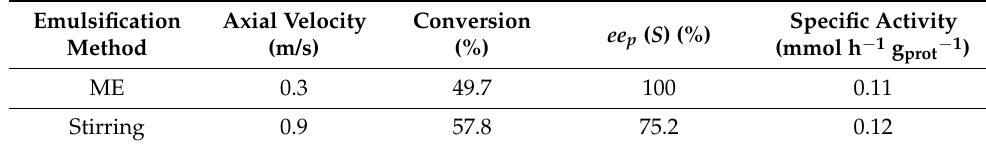
Table 2. Enantiomeric excess, conversion, and specific activity measured in enantioselective hydroly- sis of racemic naproxen methyl ester of lipase from Candida rugosa self-assembled at uniform particles interface produced by membrane emulsification (ME) and stirring method after 24 h of reaction.